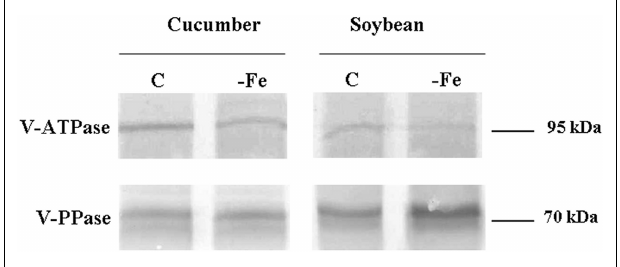
FIGURE 1 |Western blot analysis of proteins (10 μ L per lane) present in tonoplast-enriched membrane vesicle fractions isolated from cucumber (left) and soybean (right) roots grown in the presence (C) and in the absence ( − Fe) of Fe. Immunostaining was performed using polyclonal antibodies raised against theV-ATPase a subunit and theV-PPase polypeptide